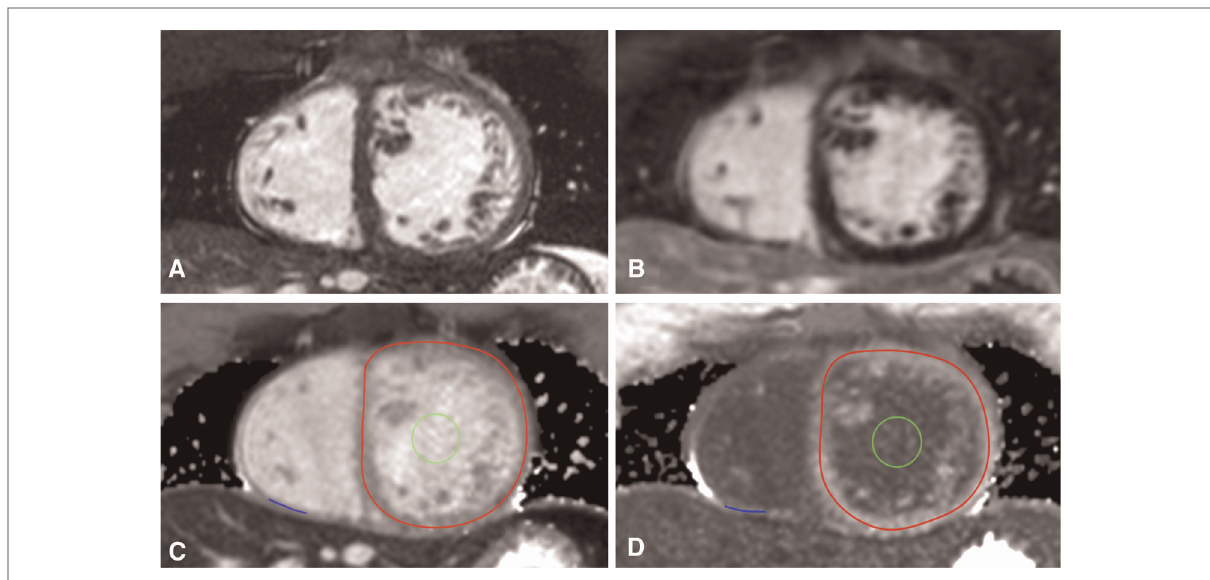
FIGURE 1 T1 mapping in congenitally corrected transposition of the great arteries. Corresponding cine ( A ) and late gadolinium enhancement images ( B ) as well as T1 maps in midventricular short axis before ( C ) and after contrast application ( D ) are shown. Lines of interest (LOIs) are drawn into the myocardium of the systemic right ventricle (red LOI) and the subpulmonary left ventricle (blue LOI). The blood pool is marked with a green region of